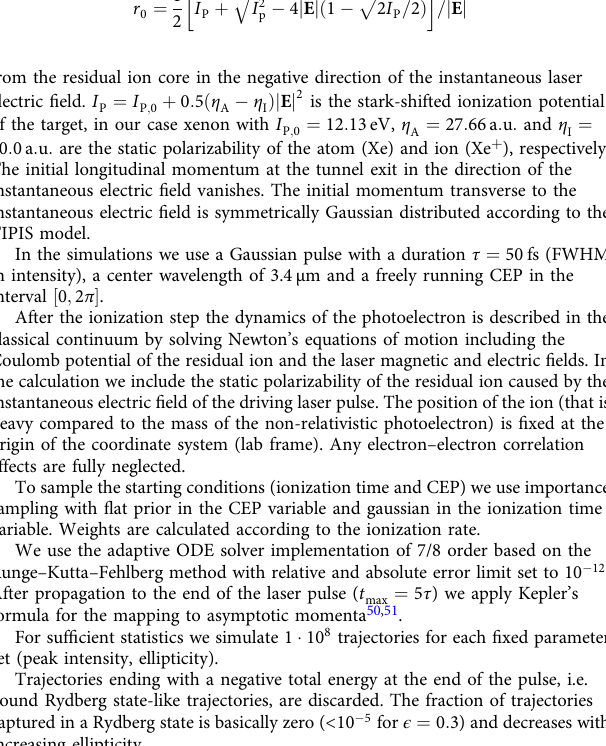
Methods Laser system . We use an optical parametric chirped pulse ampli fi er system that delivers ultrashort laser pulses at a center wavelength of 3.4 μ m with a pulse duration of 50 fs, a pulse energy of up to 20 μ J at a repetition rate of 50kHz 43,44 and with random CEP 37 . The polarization state of the laser beam is fully controlled with a broadband custom-made quarter-wave plate and a subsequent half-wave plate (B. Halle). The fi rst waveplate controls the ellipticity and the second one the orientation of the polarization ellipse. Both waveplates were fully characterized by optical polarimetry measurements (see Supplementary methods).